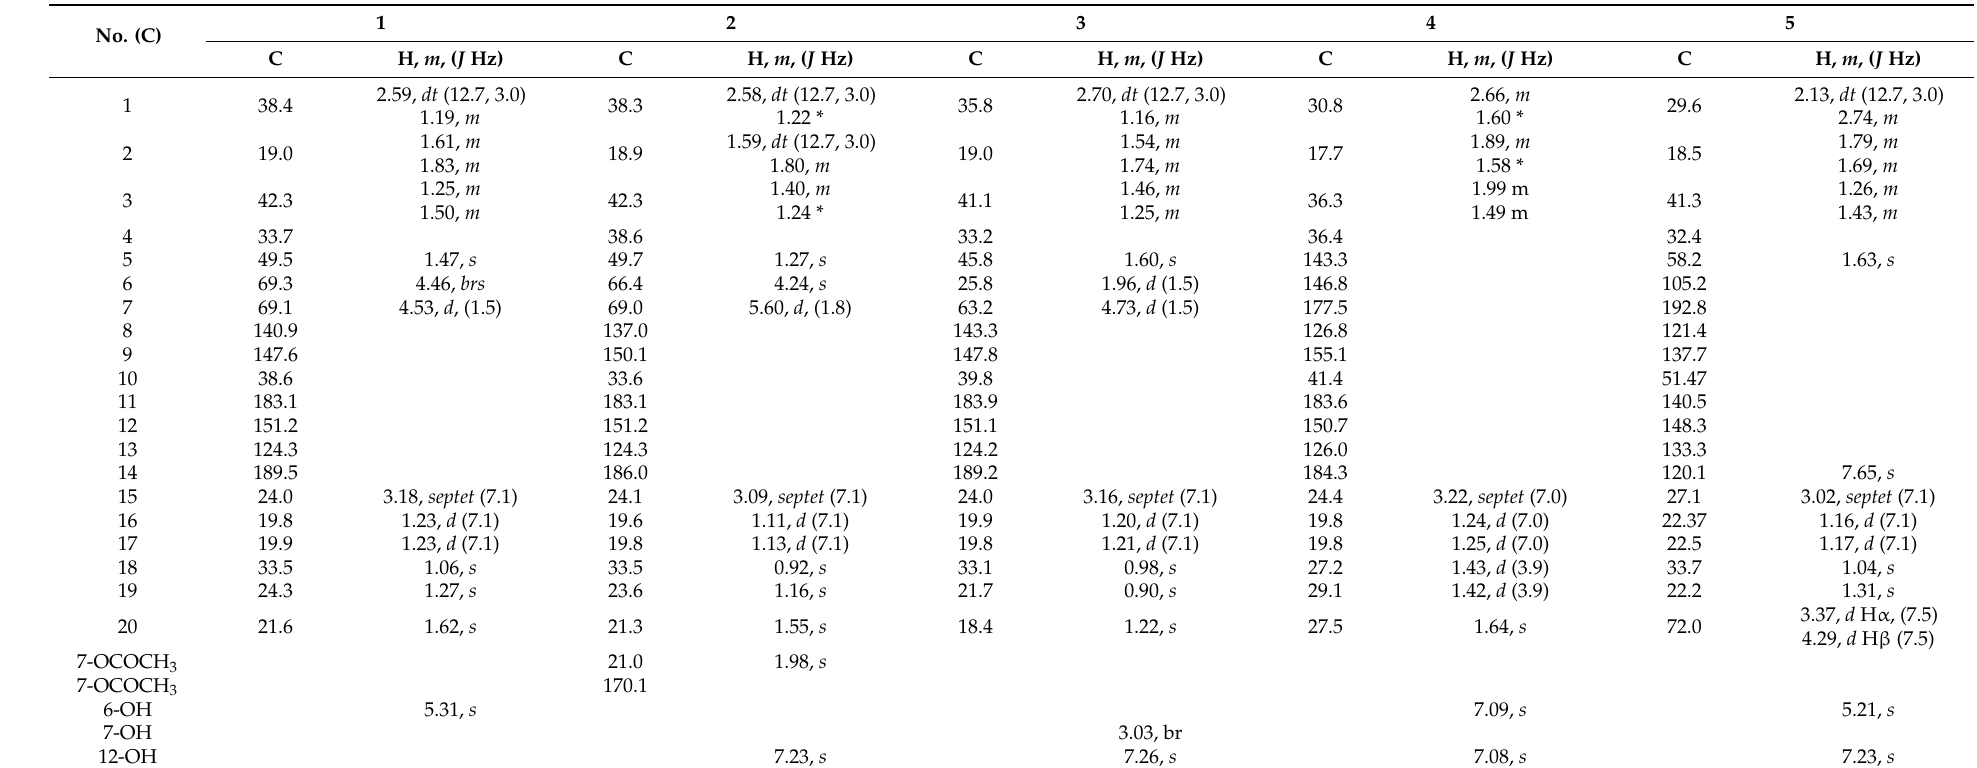
Table 1. NMR data of compounds 1 – 5 in CDCl 3